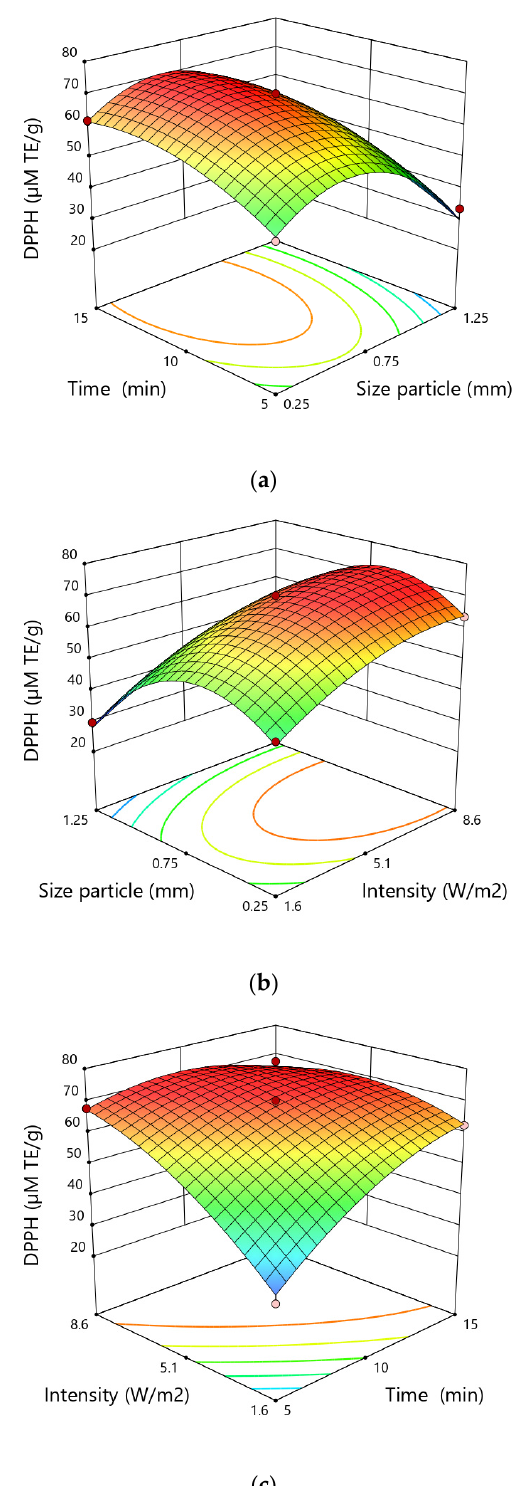
Figure 3. Response surfaces for the DPPH test ( µ MTE · g − 1 ) showing the effect of ( a ) time and particle size, ( b ) size particle and intensity, ( c ) intensity and time.